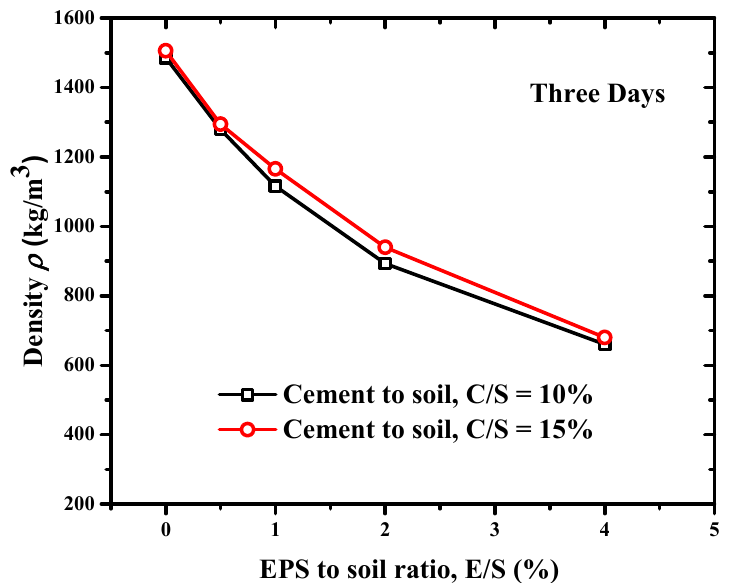
Figure 6. E ff ect of EPS to clay (E / S) and cement to clay (C / S) ratios on the density of EPS-cement Figure 6. Effect of EPS to clay (E/S) and cement to clay (C/S) ratios on the density of EPS-cement lightweight lightweight clay.